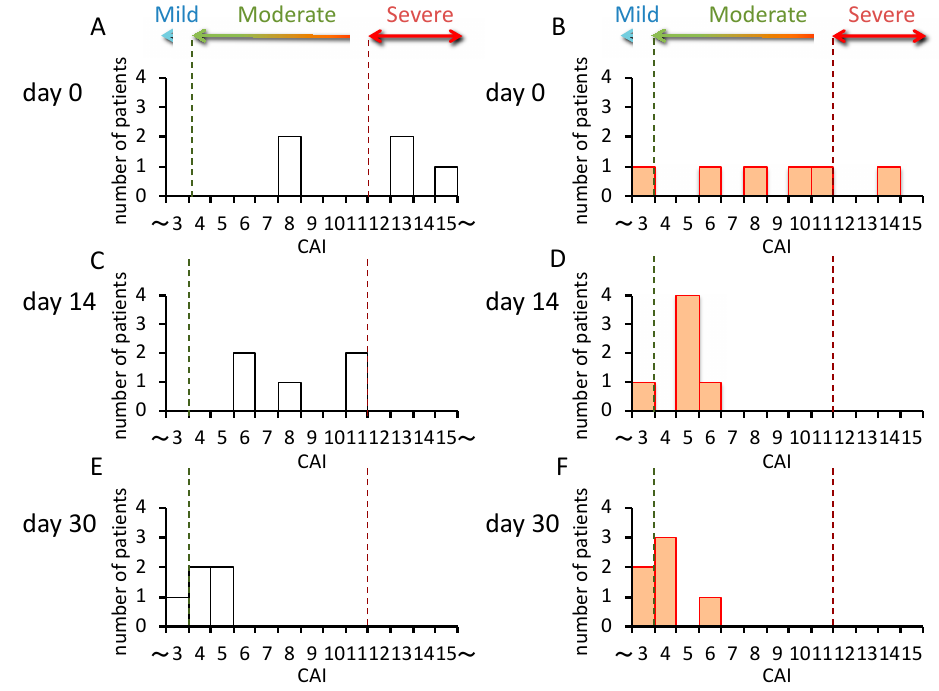
Figure 3. Change in the clinical activity index (CAI) in the CYP3A5 genotype after the start of tacrolimus therapy. The white bars indicate the number of patients carrying the CYP3A5*1/*3 genotypes (CYP3A5 expressor, n = 5) ( A , C , E ). The orange bars indicate patients carrying the CYP3A5*3/*3 genotype (CYP3A5 nonfunctional, n = 6) ( B , D , F ).